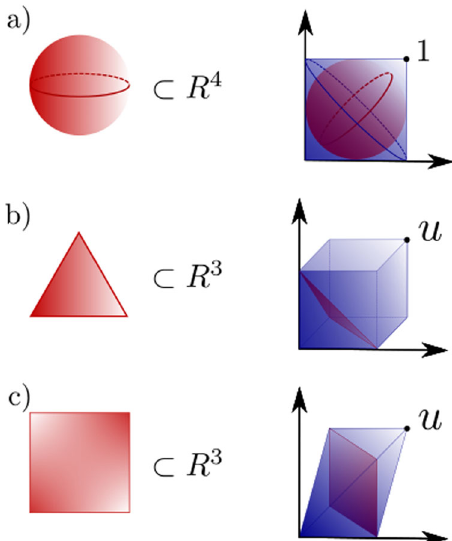
Fig. 1 The geometry of states and effects. The geometry of the set of states (to the left) and effects (to the right) for ( a ) atomic quantum systems of dimension d = 2, ( b ) atomic classical systems of dimension v = 3, and ( c ) atomic Boxworld systems of dimension ( n , k ) = (2,